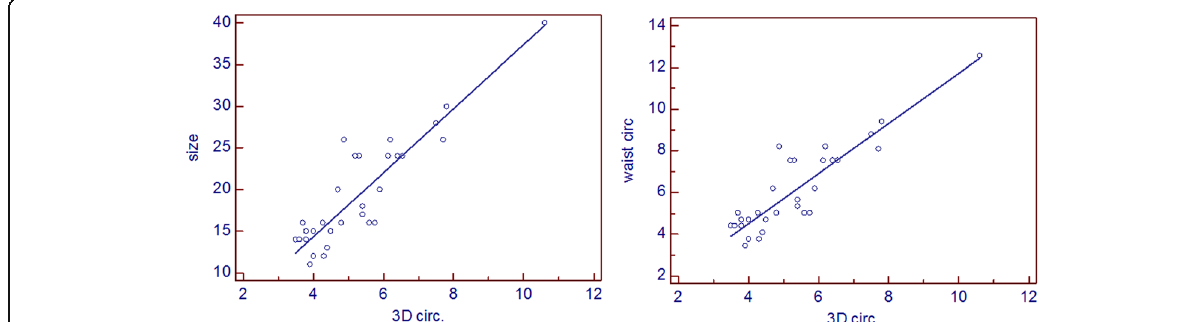
Fig. 5 Linear correlation showing a strong significant correlation between 3D derived defect circumference and device size used for ASD transcatheter closure (left panel) and device waist circumference (right